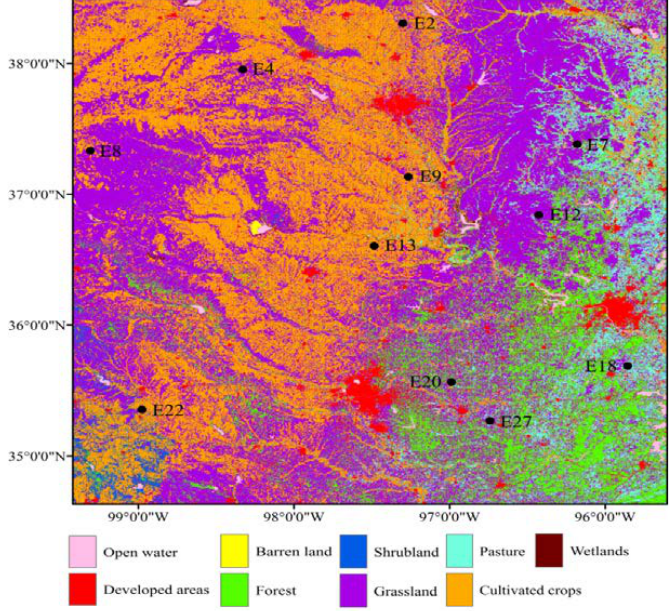
Figure 1. Distribution of the Bowen ratio stations over SGP region on a United States Geological Survey (USGS) land cover map.